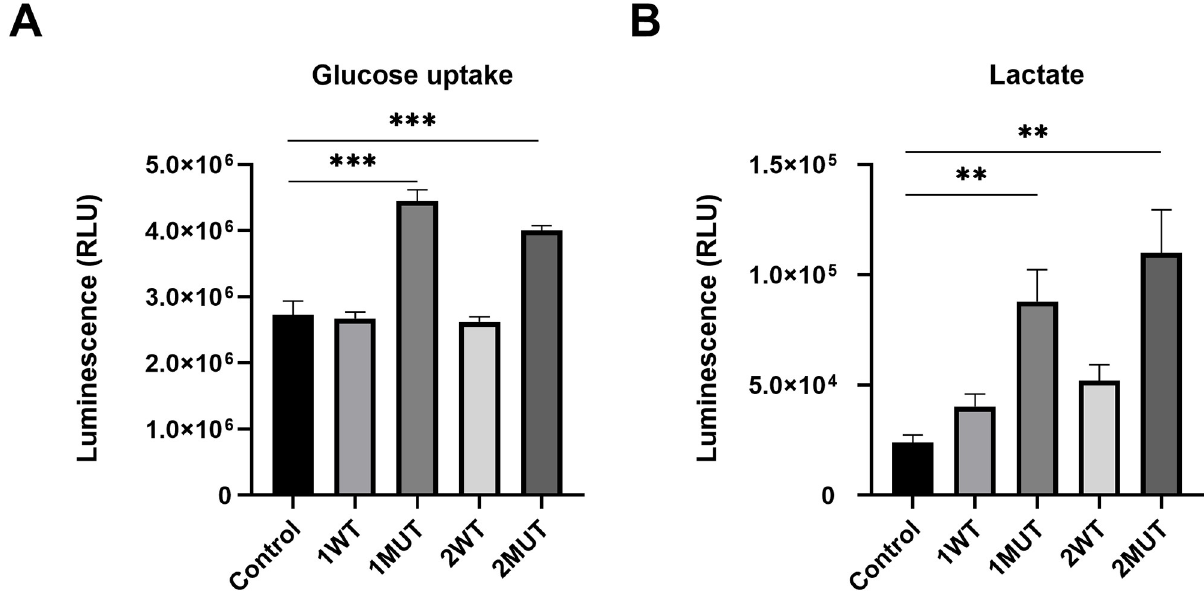
Fig 4. Augmentation of glucose uptake and intracellular lactate levels by the IDH1/2 mutants. (A) Glucose uptake levels in MEF-1WT, MEF- 1MUT, MEF-2WT, MEF-2MUT, and the control cells were measured by a bioluminescent assay based on the detection of 2DG6P. The data represent mean ± SD of three independent experiments. ��� p < 0.001. (B) Intracellular lactate levels in the MEF cells indicated in (A) were measured by a bioluminescent assay for the detection of L-lactate. The data represent mean ± SD of three independent experiments. �� p < 0.01.